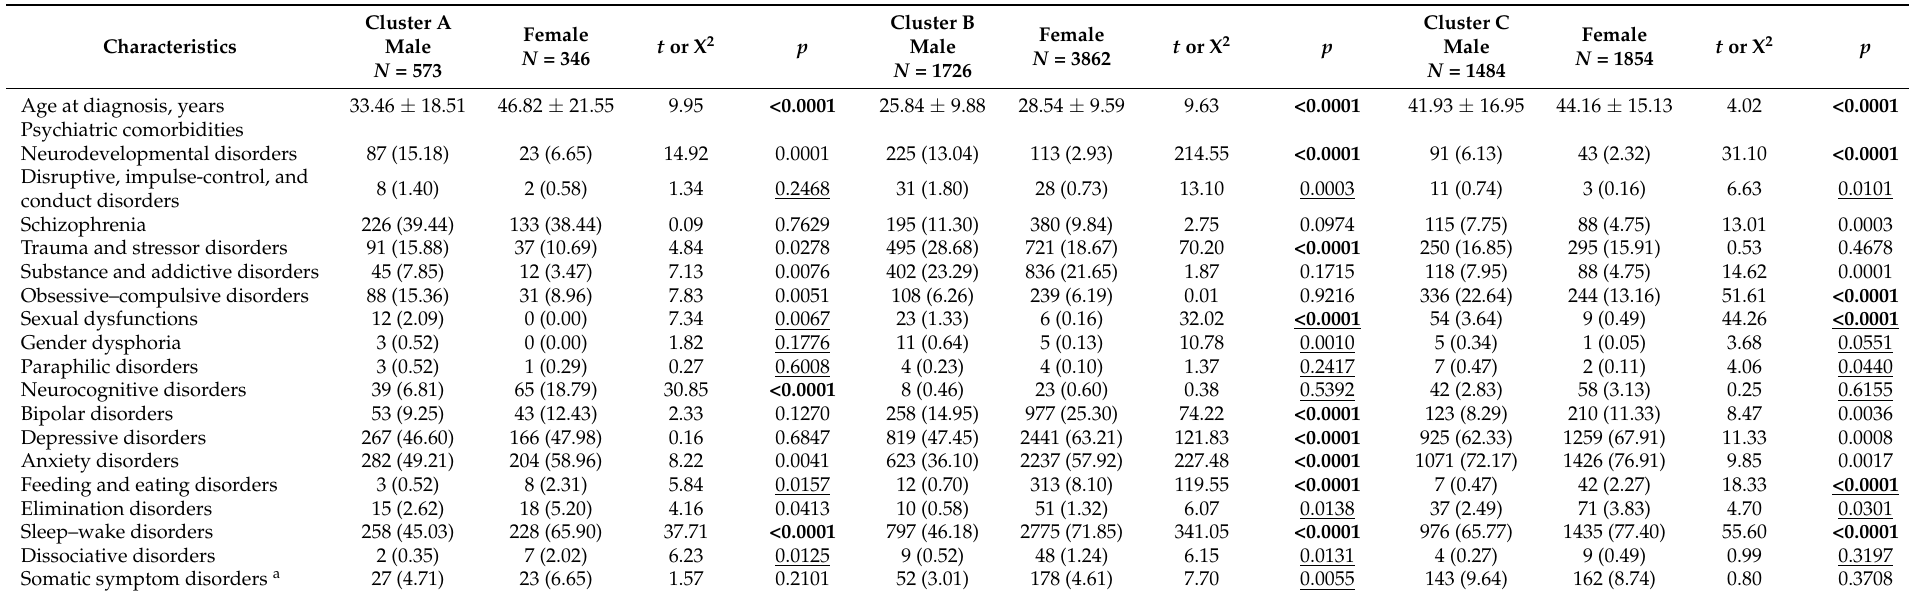
Table 2. Gender differences in cluster A, cluster B, and cluster C personality disorder